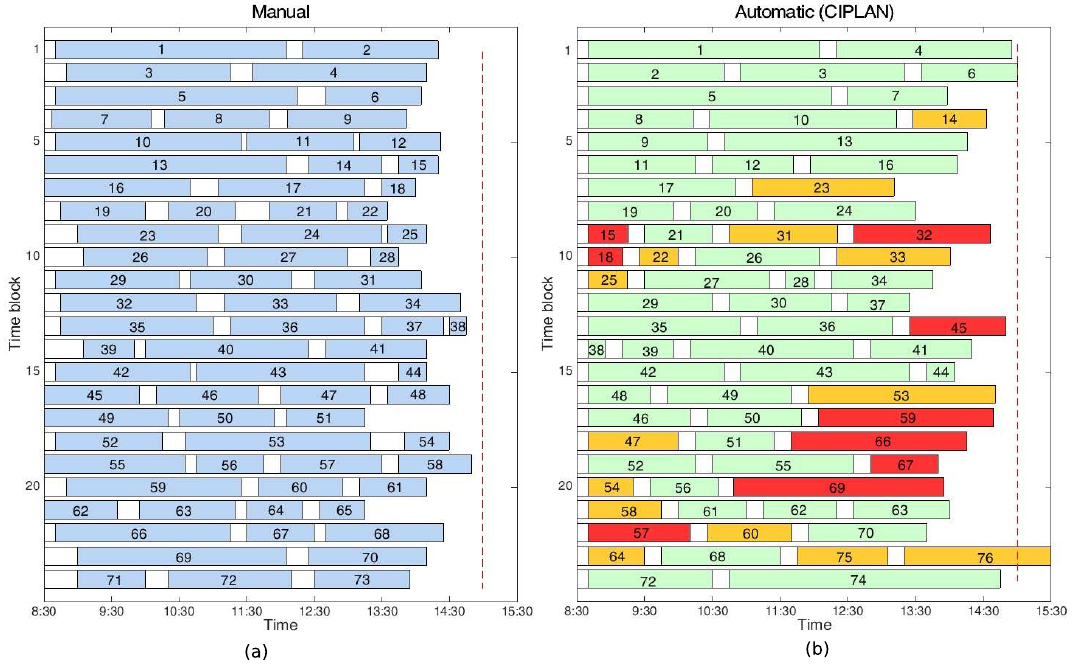
Figure 5. Comparison of the time execution of the surgical blocks. The time execution of the 24 time blocks scheduled ( a ) manually and ( b ) using CIPLAN are compared. Numbers inside the boxes represent the preference order of the patients. In case ( b ) color green/orange/red means that the patient has been advanced or delayed at most 1/2/3 time blocks with respect to the manual